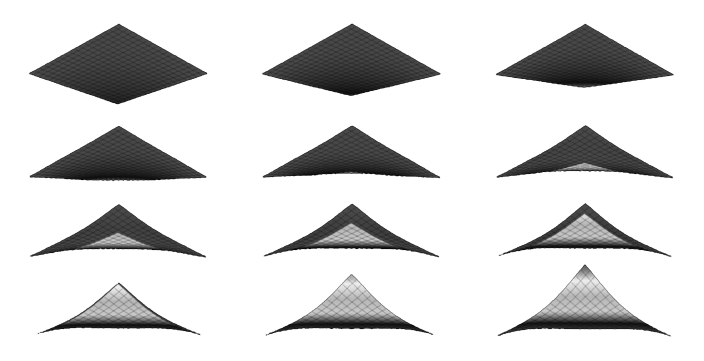
Figure 5: Staaks